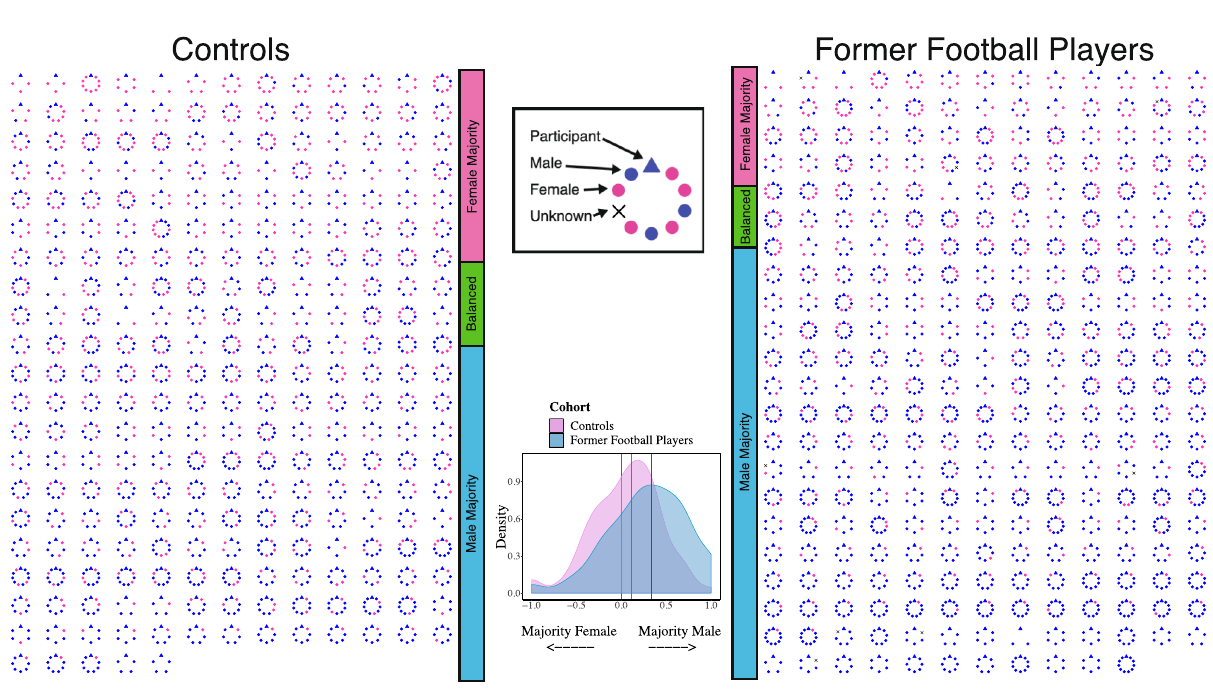
Figure 2. Male and female persons within networks of the two groups. Networks are ordered, from top left to bottom right, by the degree to which networks are majority female, balanced between female and male persons, or majority male. A summary of the sex distribution of the networks is visualized by a density plot. Participants with networks < 2 or entirely missing data are not included in the montages. Former football players are more likely to be surrounded by men than